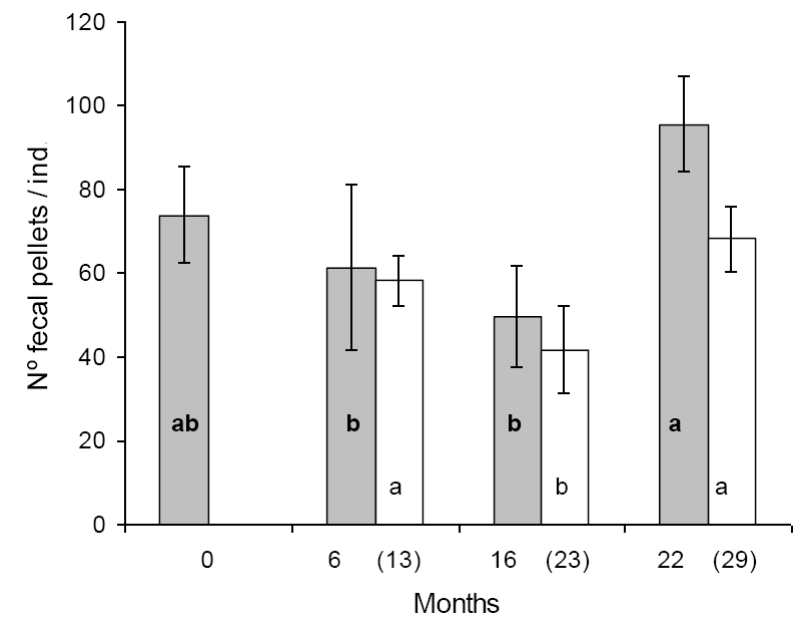
Figure 2. Average number of fecal pellets per individuals (±SD) in F. candida populations fed continuously on Bt-maize for various numbers of months. Grey bars represent initial exposure (first set of experiments). White bars represent repeated exposure (second set of experiments). Different lower case letters indicate significant differences at p < 0.05. Bold lower case letters refers to grey bars, others to white ones. Number of months at the initial and repeated (in parenthesis) exposure are indicated on the x-axis.